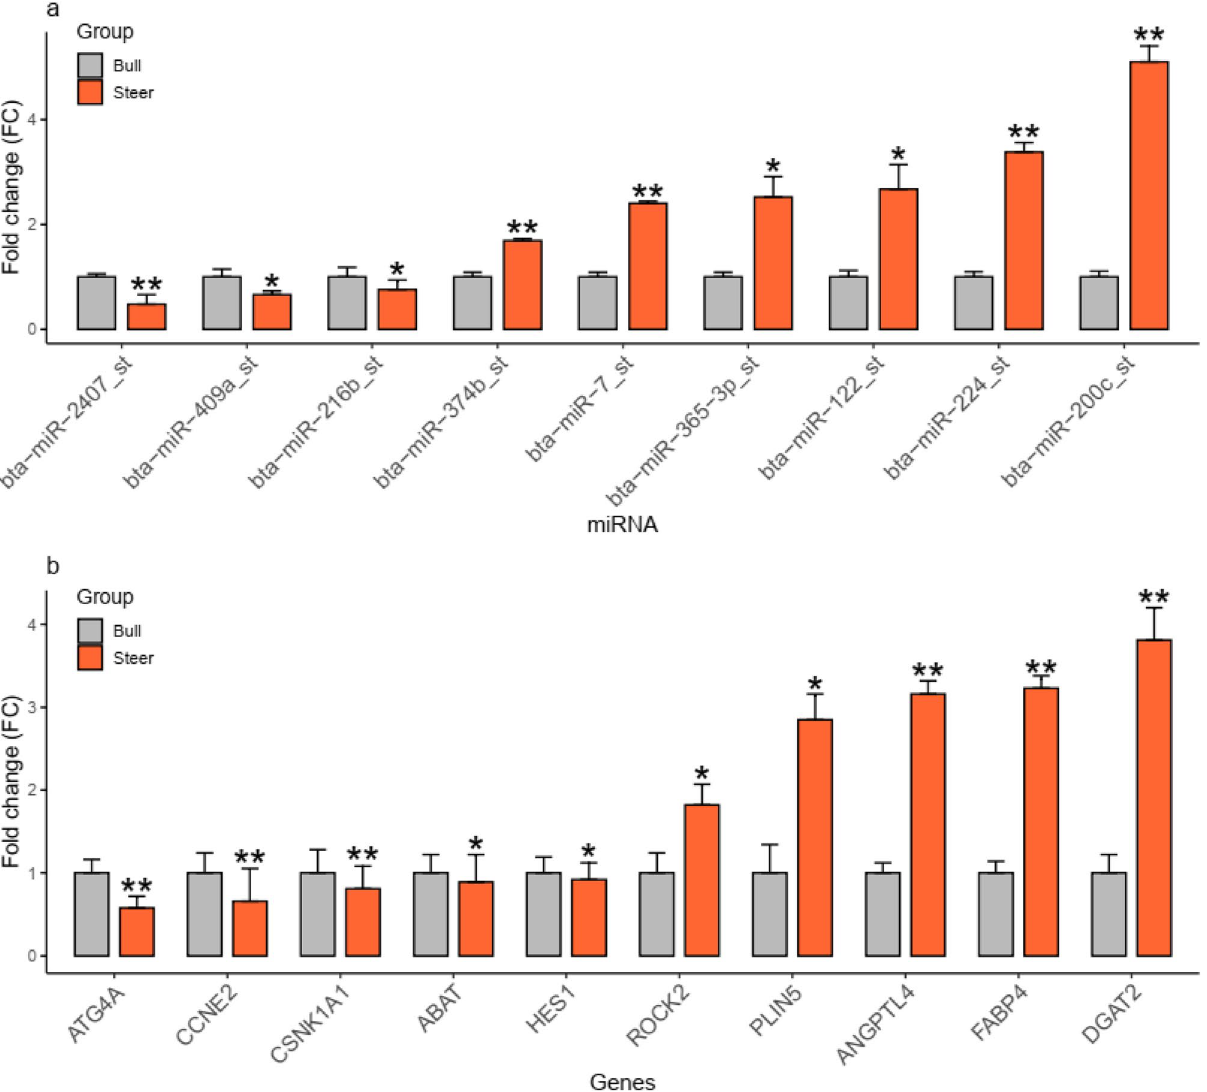
Figure 8. Experimental verification by using qRT-PCR. ( a ) shows the validation of differentially expressed miRNAs, * P < 0.05, ** P < 0.01; ( b ) presents the validation of intersection genes, * P < 0.05, ** P <